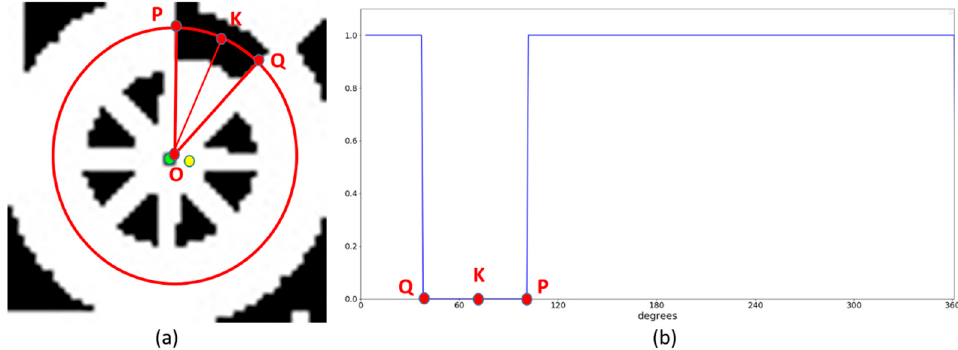
Figure 10. Detected center and direction of marker ( a ) using our Profile Checker v2; ( b ) Profile visualization from the red circle of Figure 10a.